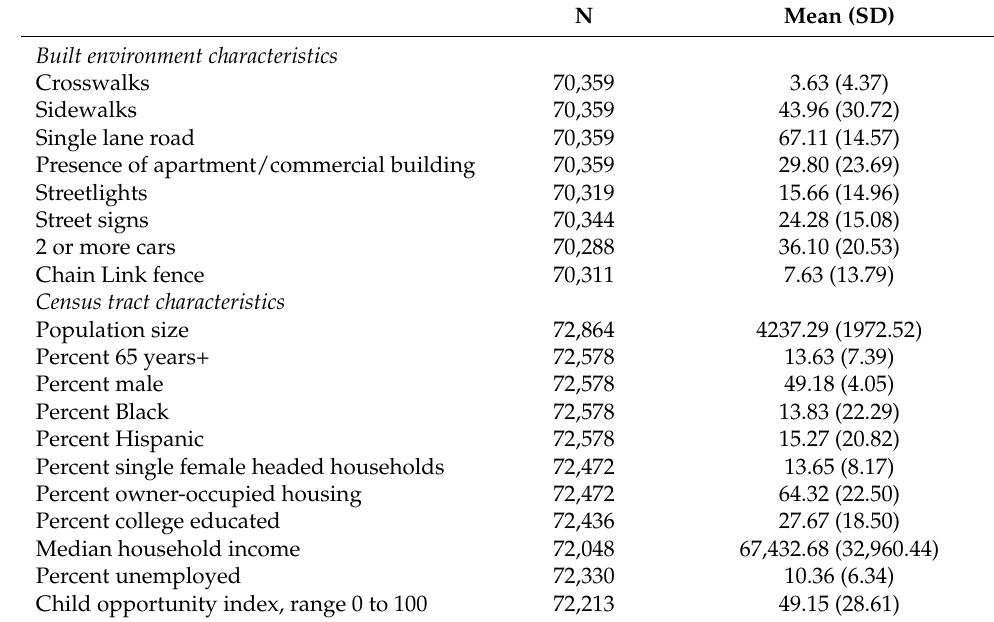
Table 1. Descriptive statistics of neighborhood characteristics and health outcomes, census